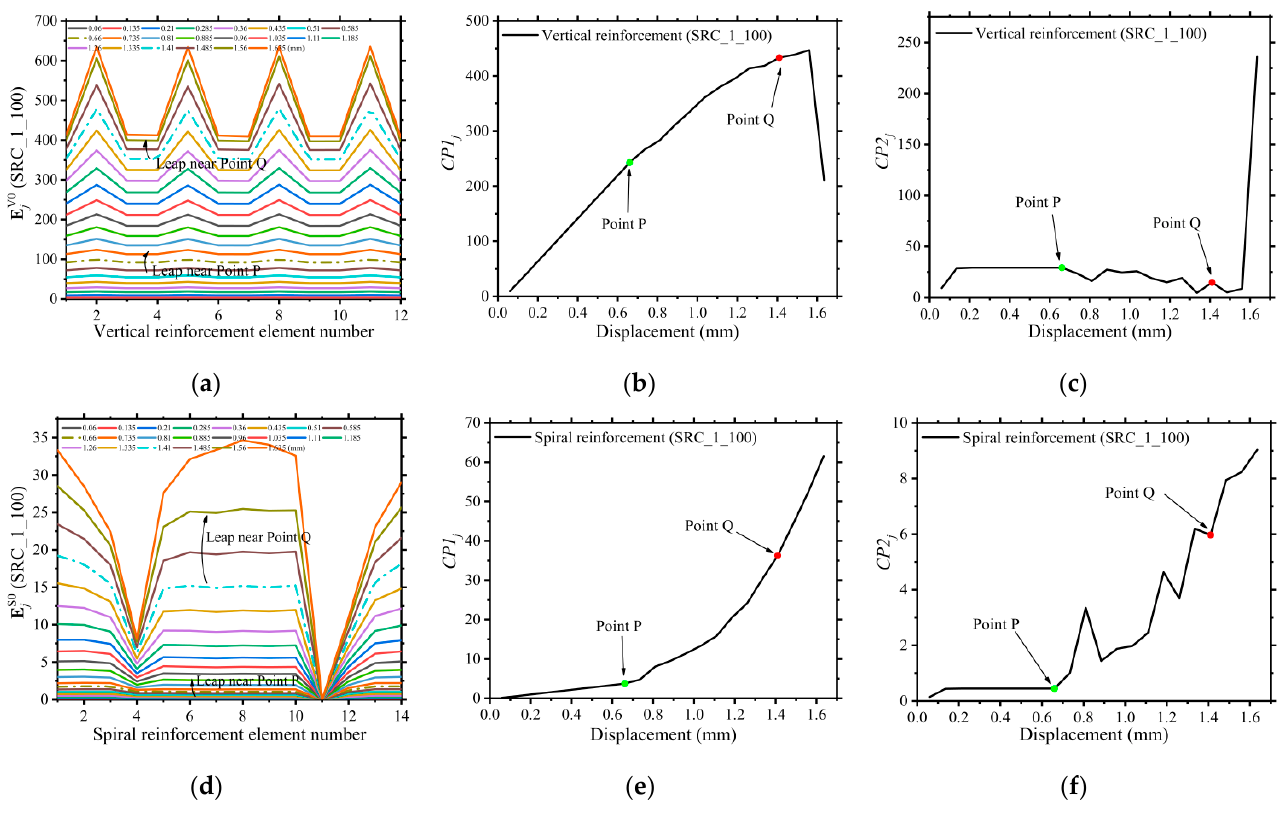
Figure 8. Stressing state characteristic pairs of sub-modes based on vertical and spiral reinforcement: ( a ) Mode0 of vertical reinforcement; ( b ) CP 1 of vertical reinforcement; ( c ) CP 2 of vertical reinforcement; ( d ) Mode0 of spiral reinforcement; ( e ) CP 1 of spiral reinforcement; ( f ) CP 2 of spiral reinforce- ment.